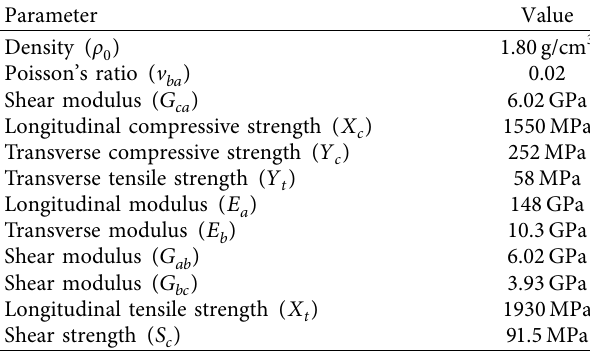
Figure 2: FEA model (a) without weakening groove and (b) with weakening groove. Table 1: Material properties of unidirectional